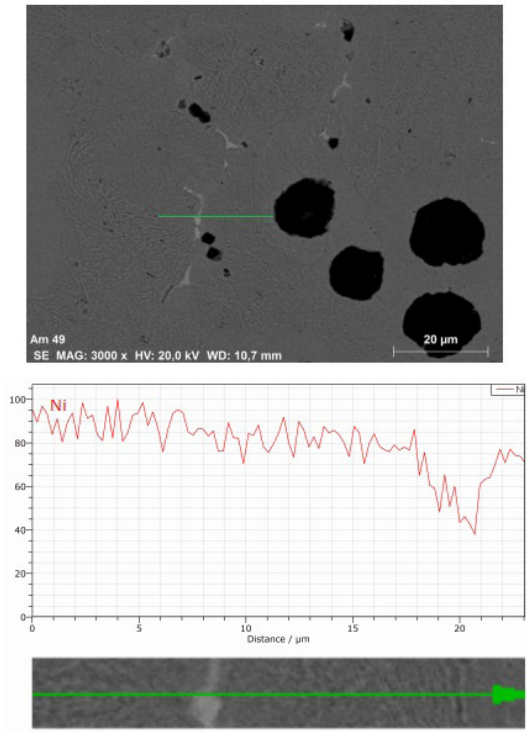
Figure 17. Matrix for Ni/Mo addition.